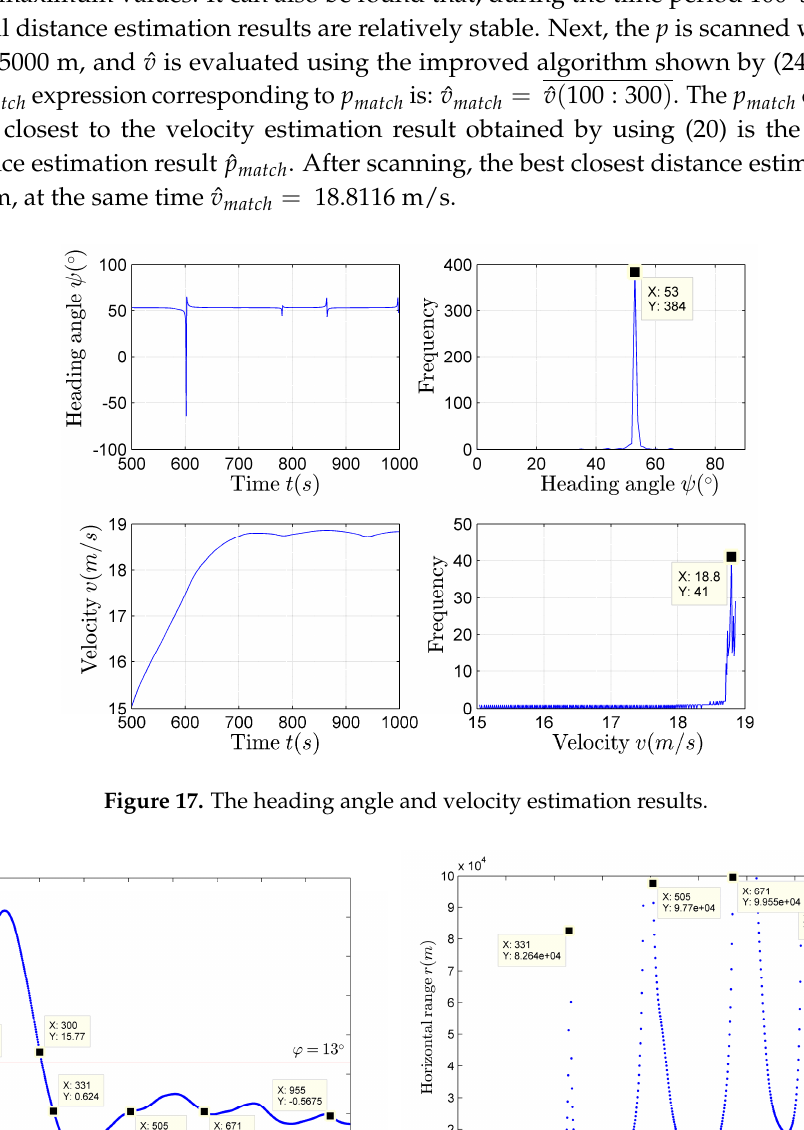
Figure 19. The estimation results of the horizontal distance before and after compensation. The parameter estimation results of the target in the horizontal direction are listed in Table 3. Table 3. The parameter estimation results in the horizontal direction. Motion Parameters